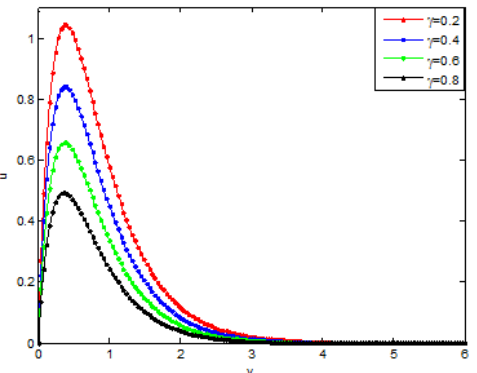
Figure 3. Effects of Casson parameter on the velocity profile of the Casson nanofluid